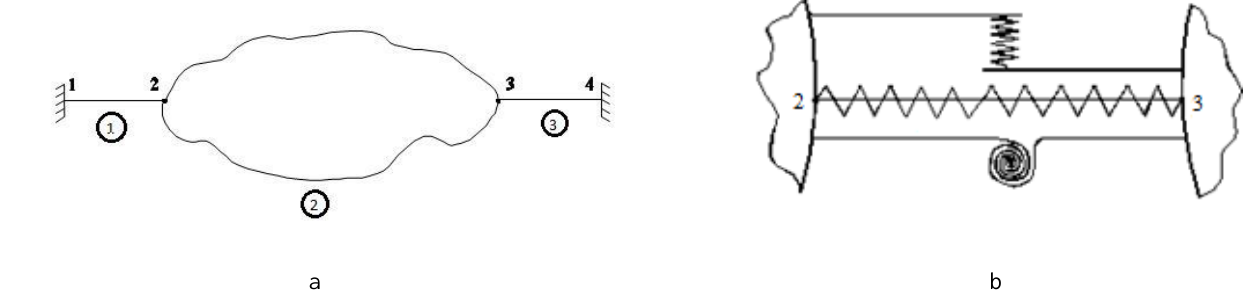
Fig. 3. The calculation scheme for determining the stiffness characteristics of two-node superelement (a) and its approximation